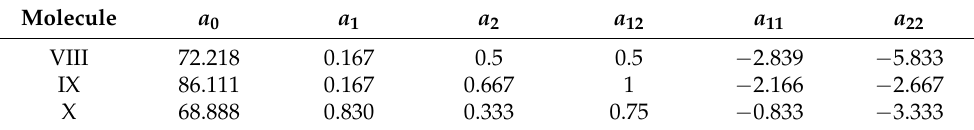
Table 4. Regression coefficients for the analyzed molecules.